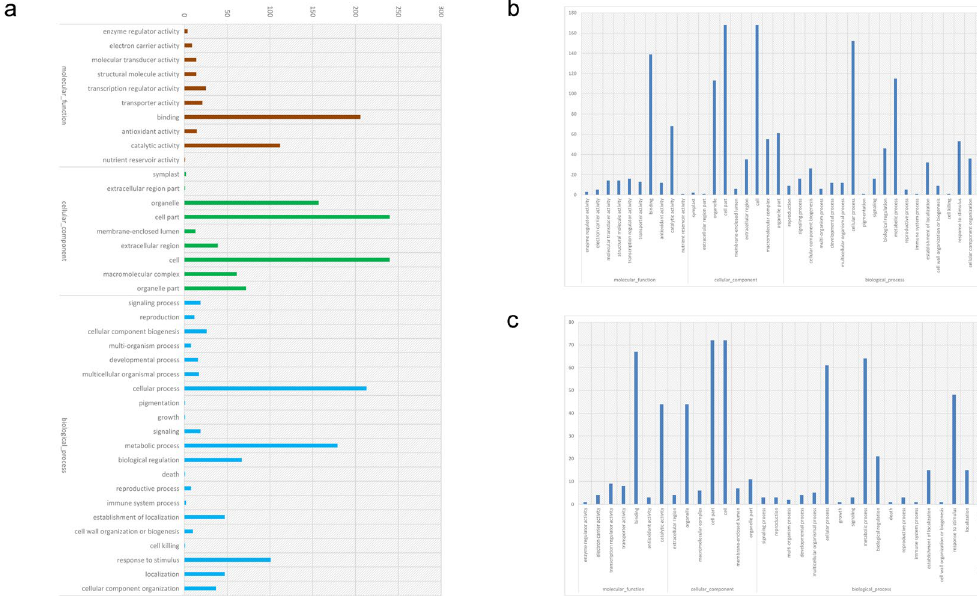
Figure 2. GO classification of differentially expressed genes in the transcriptome sequencing experiment. ( a ) The GO classification of all 805 differentially expressed genes detected in this study; ( b ) GO classification of the upregulated differentially expressed genes; ( c ) GO classification of the downregulated differentially expressed